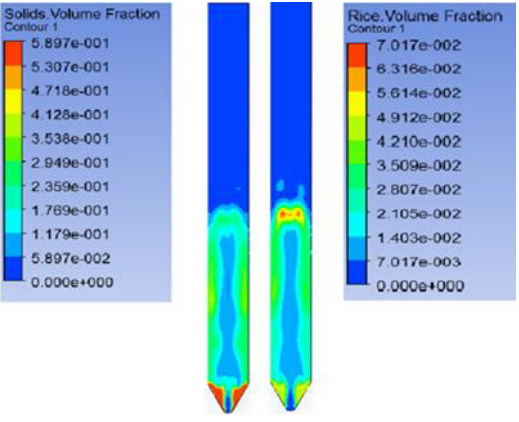
Figure 9. Volume fraction of sand ( left ) and rice straw ( right ) in a spouted bed.